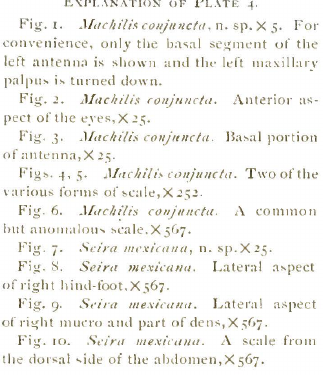
Fig. 2. J.l!aclu'/i:; ro1~juucta. 1\nterior as pect of the eyes, X 15. Fig. 3· Jlachi!i.< colljtlllcta. Ba"li portion of antenna, X .25. Fig,. -f· 5· Jf,tchi!t\ <'<JIIjuncta. Two of the \'arious fonn~ of ~cale,X25~· Fig. 6. Jlachi!is conjllllcla. A common hut ano1nalon' s~ale,Xs67. Fig. 7~ Scira mc . ...:itaua, n. sp.X25. Fig. t). Seira me:">;z'cana. Lateral a~pect ofright hind-foot.X567. F'ig. 9· St·ira me.\·inn1a. Lateral aspect of ri'{ht mucro and part of dens, X _::,67. Fig. 10. Scira me.vicana. 1\ st:ale fro1n the dorsal 'ide of the